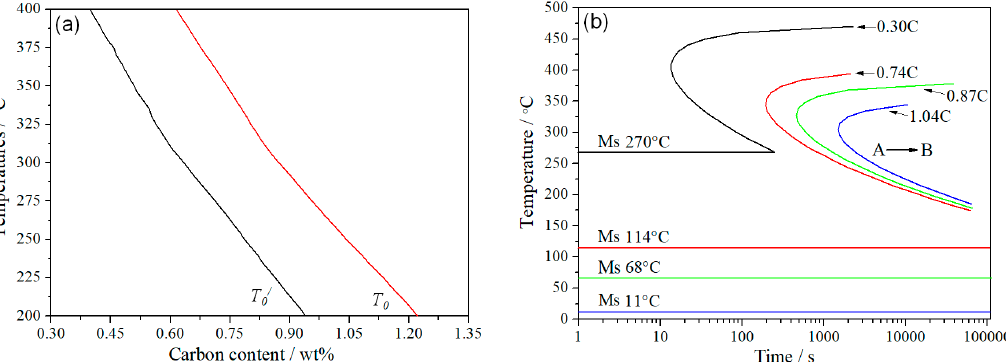
Figure 8. Calculations for ( a ) equilibrium transformation curve and ( b ) TTT isothermal bainitic transformation diagram (T 0 (cid:48) : equilibrium transformation temperature in strain energy; A e 3 : para- equilibrium transformation temperature; A → B: austenite transformed to